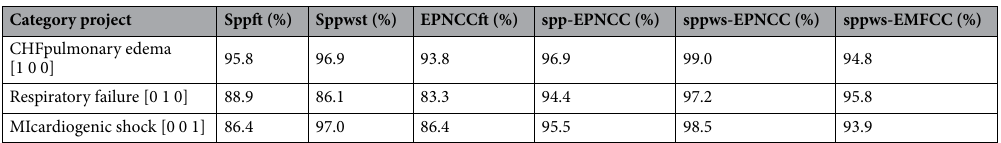
Table 5. Recall rate of each training